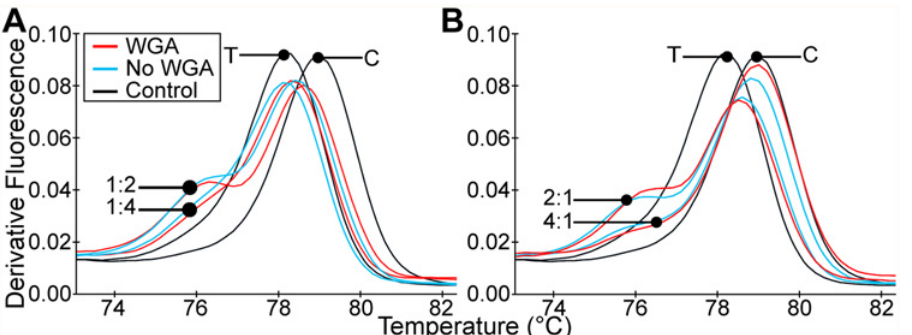
Fig 2. WGA does not affect results in HRM analysis. The derivative melt graphs show the comparison of T m profiles of a representative assay (14) tested with mixtures of monogenomic clinical samples processed with and without WGA prior to PCR. The ratios of reference (T) allele to alternate (C) allele in the mixtures were: (A) 1:2 and 1:4 and (B) 4:1 and